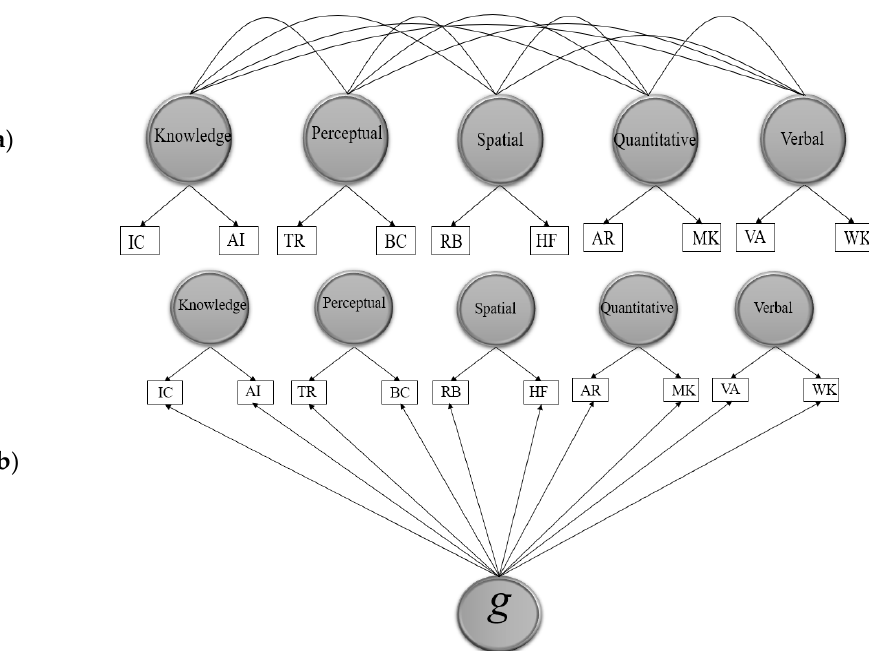
Figure 1. Representation of the AFOQT correlated-factor ( a ) and bifactor ( b ) models. Note: VA = Verbal Analogies; WK = Word Knowledge; AR = Arithmetic Reasoning; MK = Math Knowledge; RB = Rotated Blocks; HF = Hidden Figures; TR = Table Reading; BC = Block Counting; IR = Instrument Comprehension; AI = Aviation Information.